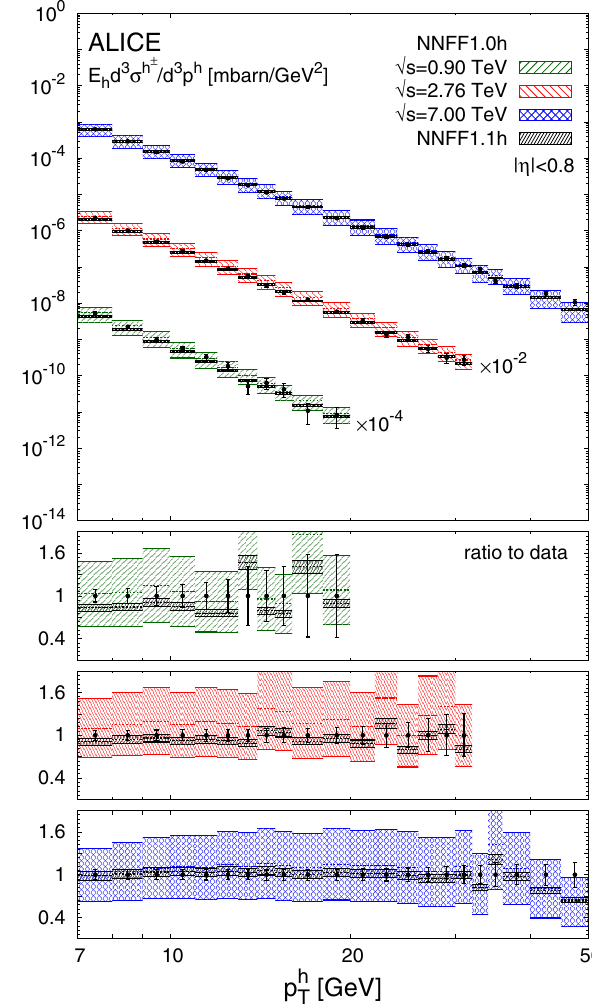
Fig. 4 Same as Fig. 3 for the (proton-proton) CMS data sets order corrections become sizeable. In Table 2, we collect the number of data points after the cut and the corresponding / N χ 2 dat values after the pp data set is used to reweight the rw NNFF1.0h set.